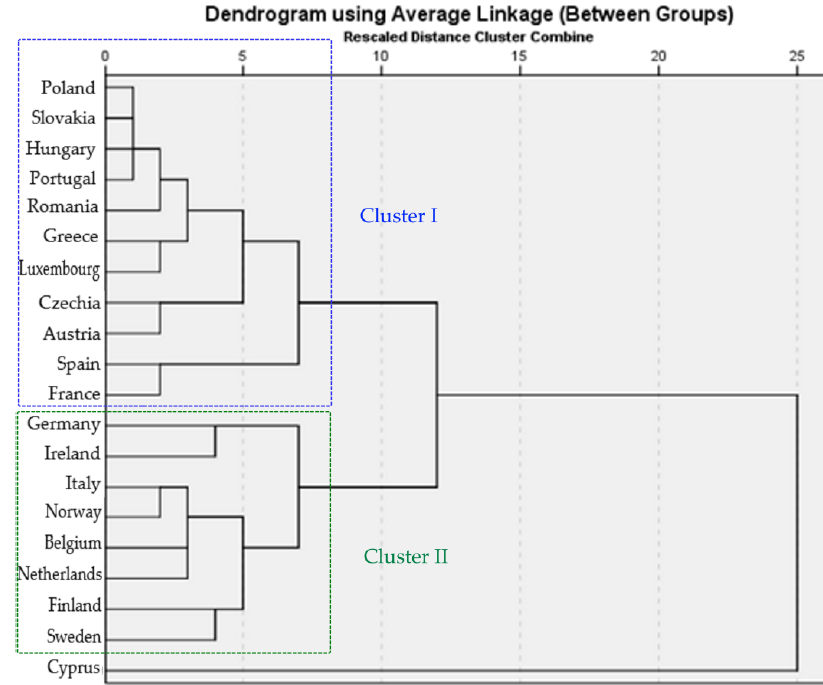
Figure 3. Dendrogram . Source: own construction using SPSS.